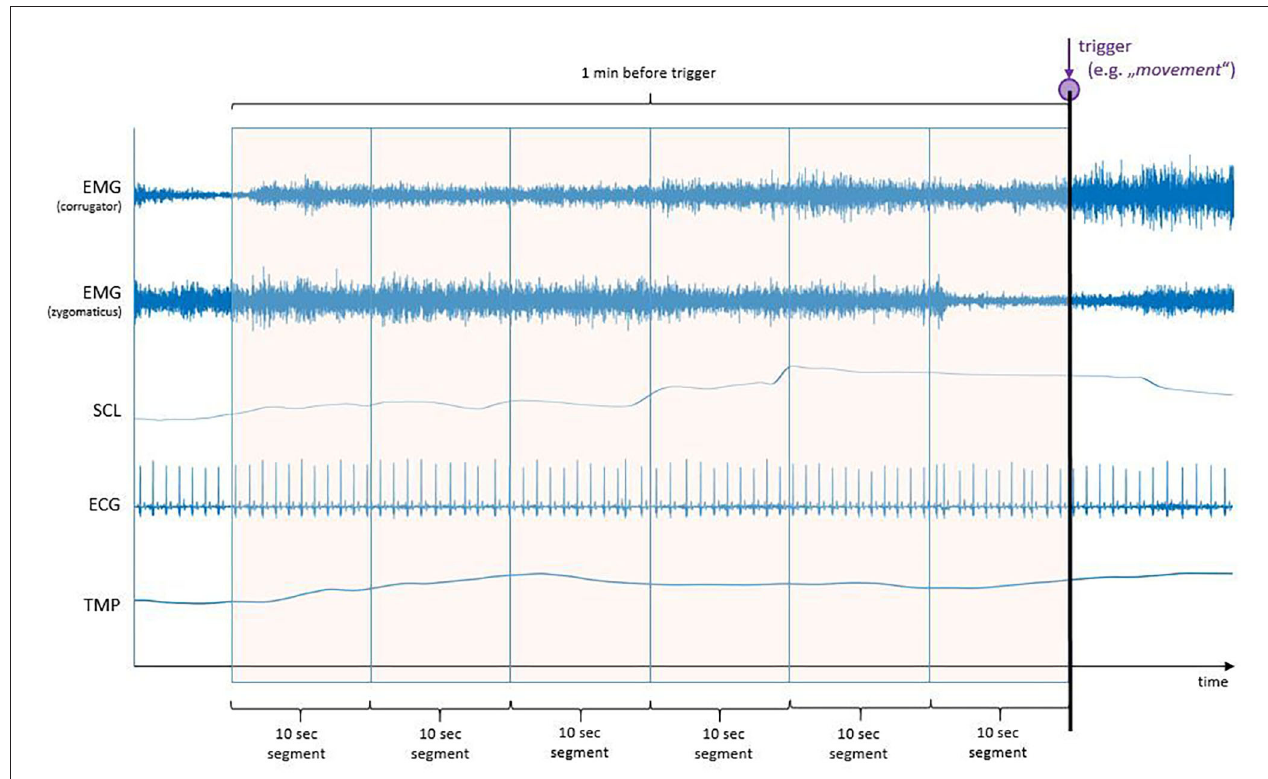
FIGURE 1 | Biosignals of autonomous nervous systems (B-ANS) response during sedation in colonoscopy.